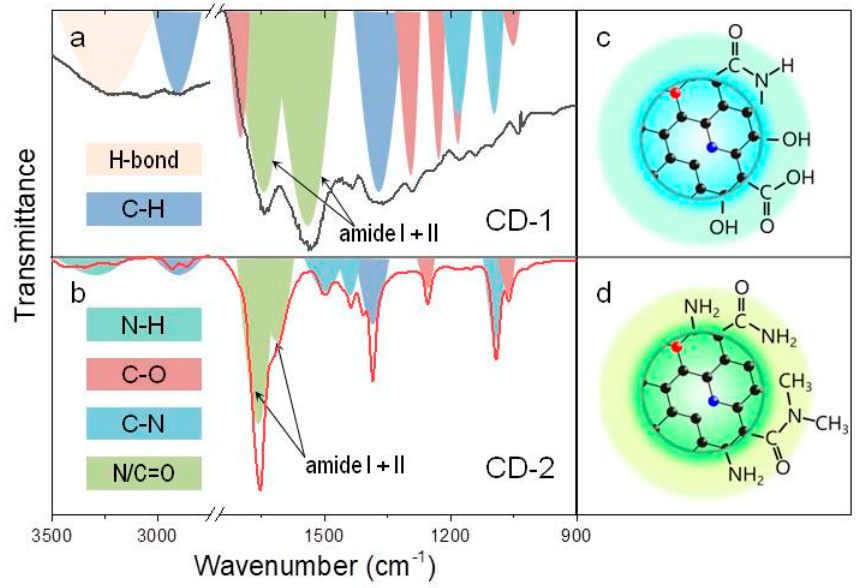
Figure 1. FTIR spectra with respective chemical bond assignments for ( a ) CD-1 and ( b ) CD-2. Schematic presentations of the surface functional groups for CD-1 and CD-2 are provided in ( c ) and ( d ), respectively. The color used for the CD cores represent their emission; graphitic and pyrrolic nitrogen atoms in the carbon network (shown in black) are given as red and blue circles, respectively.